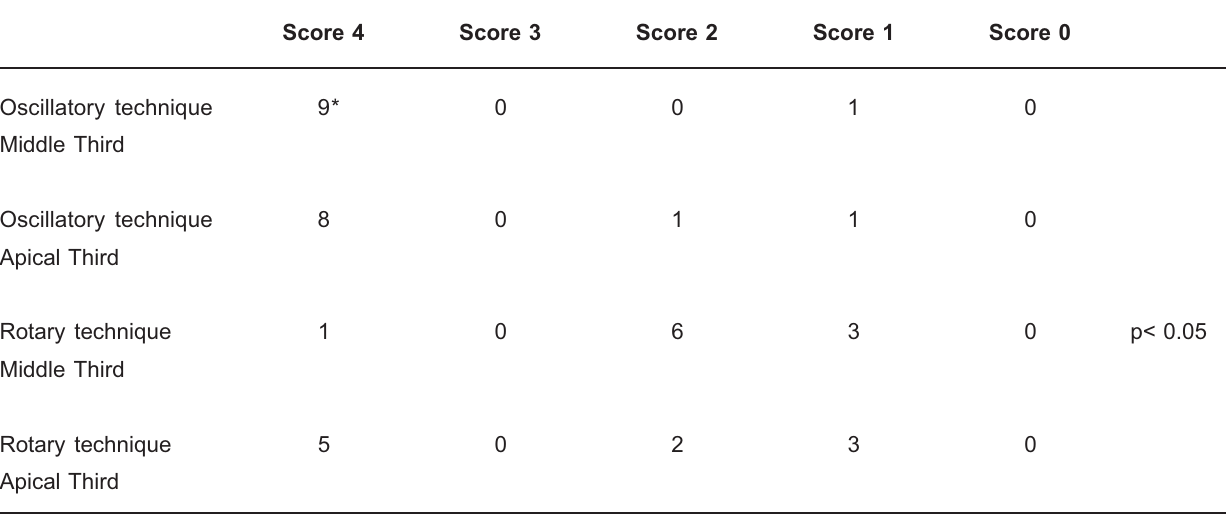
TABLE 2- General distribution of